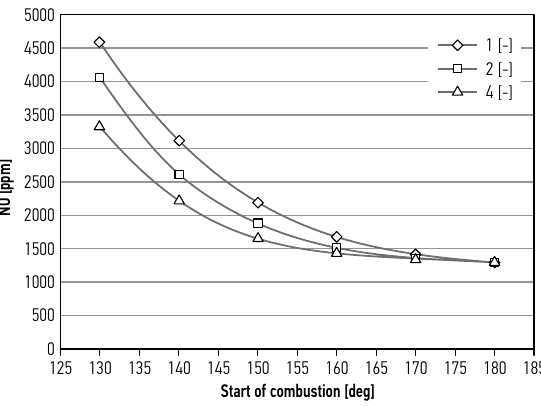
Fig. 9. NO emission as a function of combustion starting at a different shape factor of the Vibe function ( source : own